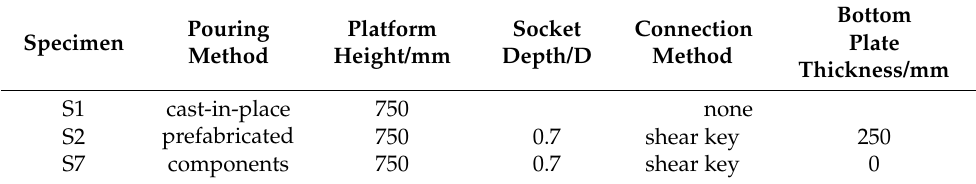
Figure 6. Structure diagram of the scaled pier.